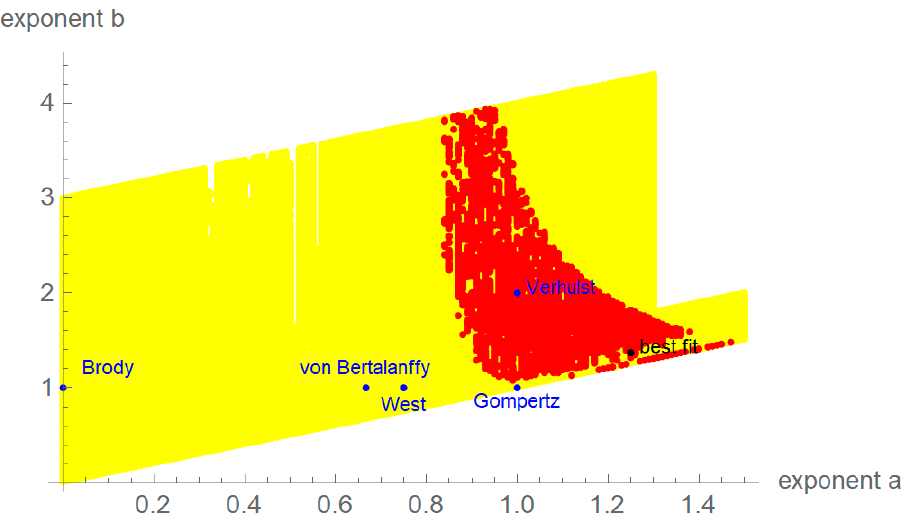
Figure 1. Exponent pairs as proxy for models. Note: search grid (yellow), exponent pairs with Akaike weight 5% or higher (red), best-fit exponent pair (black), and exponent pairs of selected named models (blue). Plot using Mathematica 12.1 based on the stock of electric cars in Austria (accumulated registration data computed from Table 1).